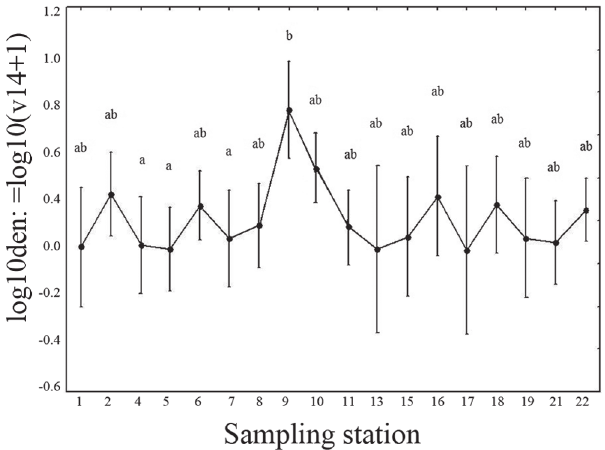
Fig. 5. Average and 95% confidence interval for the mean log (Dens. + 1) observed in the different sampling stations 10 during the period (Different letters indicate significant differences according to the Unequal HSD